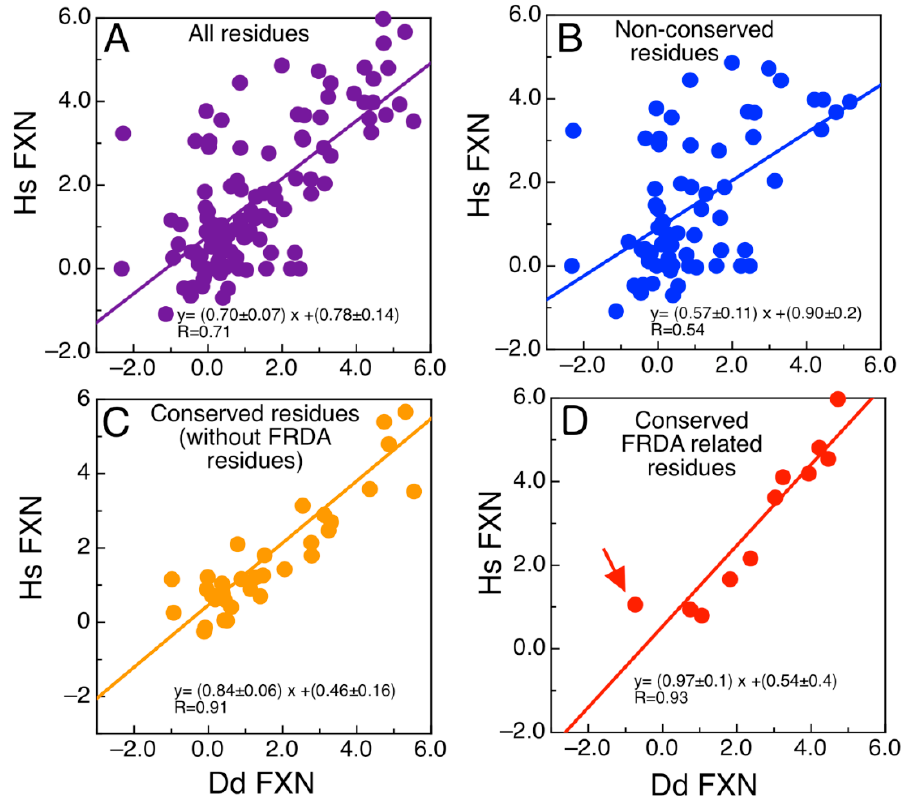
Figure 3. Analysis of the Energetics of the DdFXN Structure Model. Correlation of free energy differences between the alanine scanning using FOLDX corresponding to the DdFXN ( ∆∆𝐺 (cid:2898)(cid:2905),(cid:2888)(cid:2914)(cid:2890)(cid:2908)(cid:2898)(cid:2925) ) and human variant ( ∆∆𝐺 (cid:2898)(cid:2905),(cid:2918)(cid:2929)(cid:2890)(cid:2908)(cid:2898)(cid:3042) ) for ( A ) all the residues, ( B ) only residues that are not conserved, ( C ) only residues that are conserved but without including FRDA-related residues and ( D ) showing only residues conserved and FRDA-related. The red arrow indicates the N146A mutation. Free energy differences for each Ala mutant was calculated as follows: e.g., for N146A variant the value of ∆∆𝐺 (cid:2898)(cid:2905),(cid:2918)(cid:2929)(cid:2890)(cid:2908)(cid:2898) (cid:2925) = ∆𝐺 (cid:2898)(cid:2905),(cid:2918)(cid:2929)(cid:2890)(cid:2908)(cid:2898) (cid:2898)(cid:2869)(cid:2872)(cid:2874)(cid:2895)(cid:2925) − ∆𝐺 (cid:2898)(cid:2905),(cid:2918)(cid:2929)(cid:2890)(cid:2908)(cid:2898) (cid:2933)(cid:2930)(cid:2925) . DdFXN was modelled using the human (PDB ID: 1EKG) variant as template.